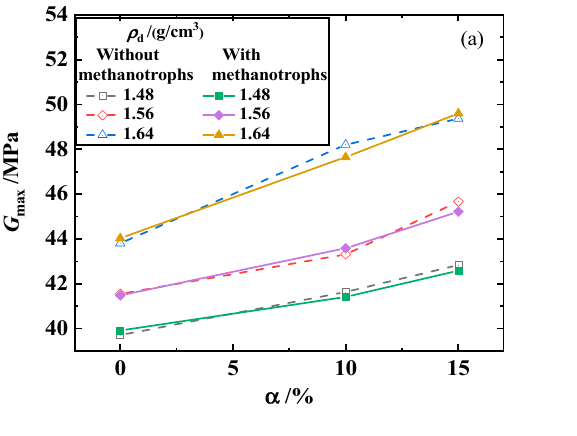
Figure 10. Comparison of G max and M max of the biochar–clay mixture with or without methanotrophs: ( a ) G max – α ; ( b ) M max – α .